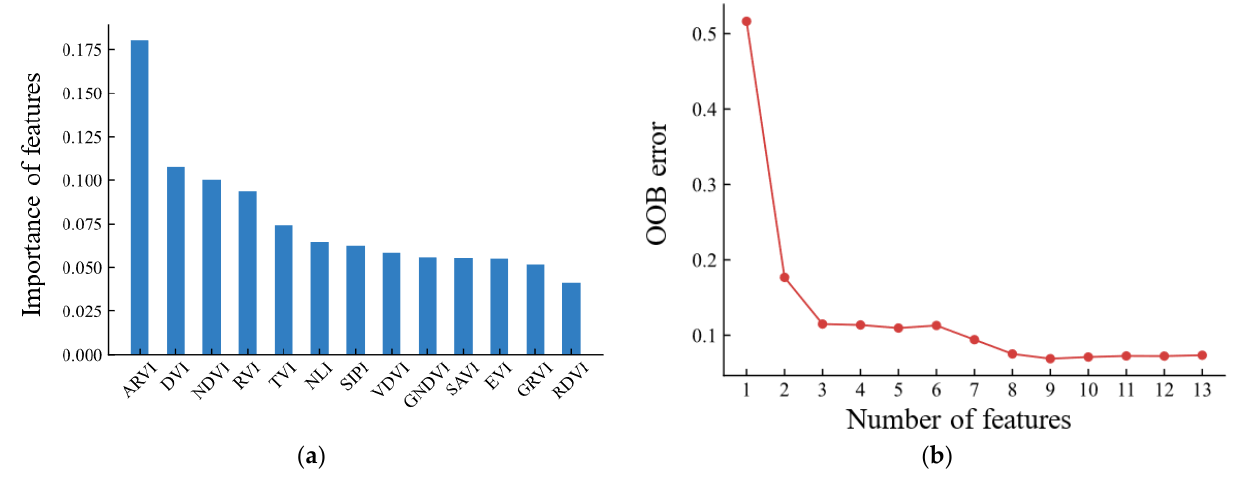
Figure 5. Importance ranking ( a ) and relationship with OOB error ( b ) of the vegetation indexes.